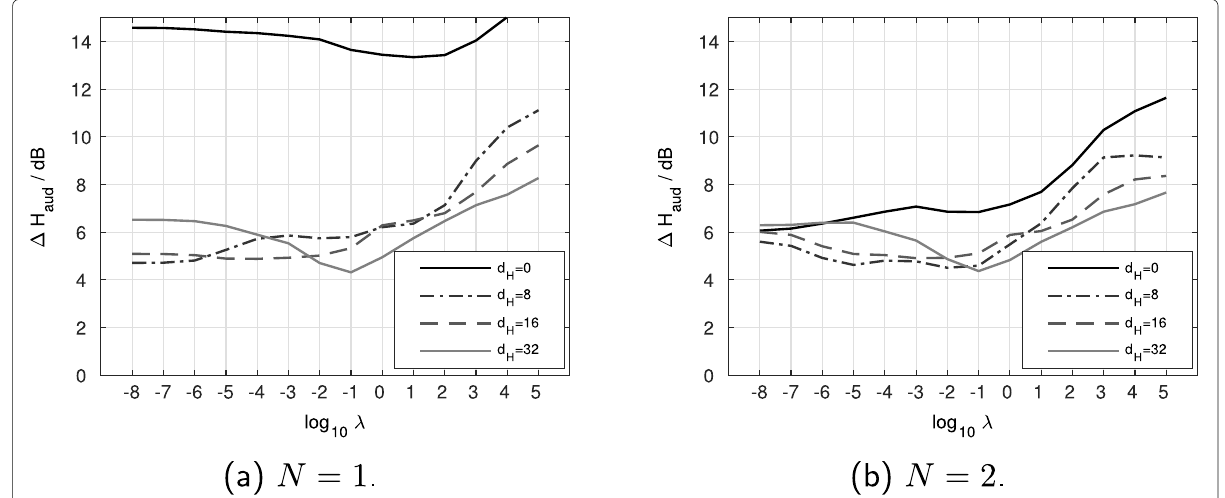
Fig. 6 Auditory spectral distance as a function of the regularization parameter λ for different acausal delays d H for a N = 1 loudspeaker and b N = 2 loudspeakers ( β = 1, G 0 = 0dB, d G =